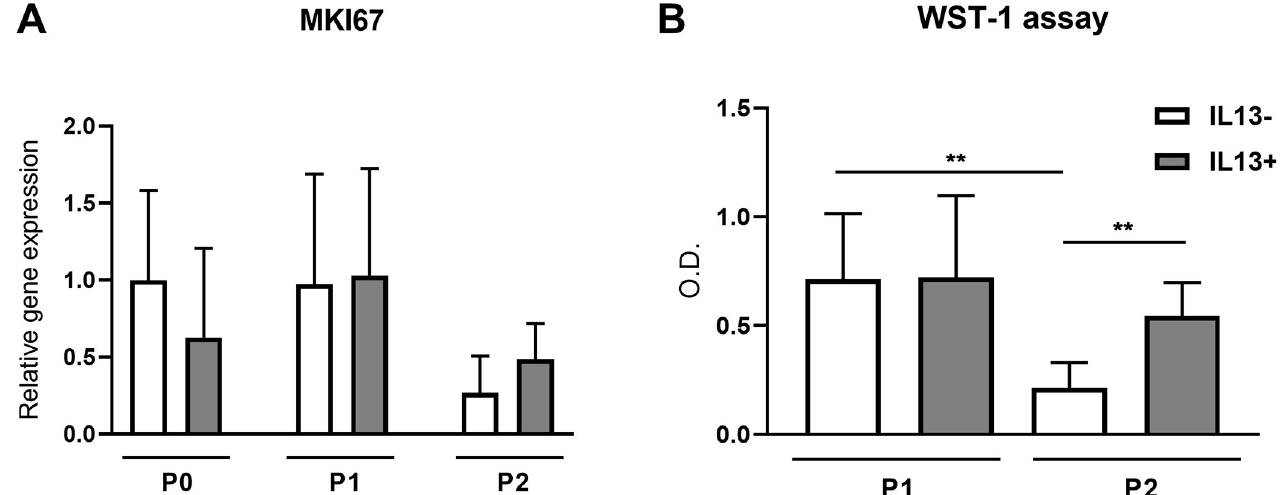
Fig 5. Relative gene expression of MKI67 and WST-1 assay in IL13- and IL13+ cell cultures. (A) Cells originating from limbal explants (P0) and passaged cells (P1 and P2) at the end of culture were analyzed for MKI67 gene expression by qPCR. Each bar represents the mean ± SD of five to ten determinations. (B) Measurement of cell proliferation after the first and second passages (P1 and P2). The WST-1 reagent was added to the cell cultures for 1 h to form formazan. The absorbance was measured at a wavelength of 450 nm via optical density. Each bar represents the mean ± SD of eight to ten determinations. The asterisks represent a statistically significant difference between the examined groups ( �� P �